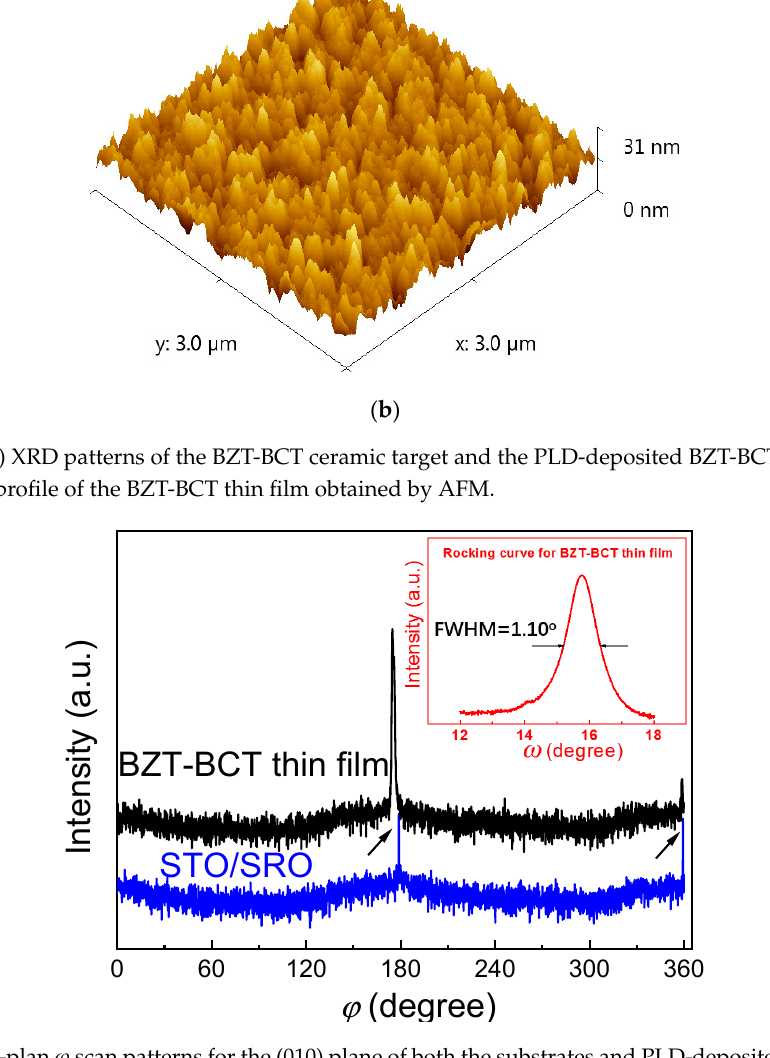
Figure 2. In-plan ϕ scan patterns for the (010) plane of both the substrates and PLD-deposited BZT- BCT thin films (the rocking curve of the BZT-BCT thin film is shown in the inset). The arrows indicate the two peaks in the ϕ scan.